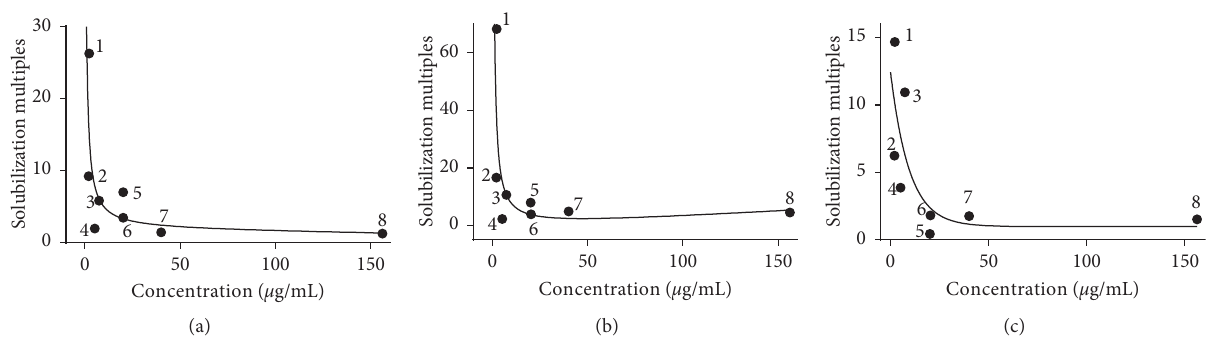
Figure 3: Relationship between solubilization and self-solubility of 8 flavonoids in NXDT, CCDT, GQDT. (a) NXDT; (b) CCDT; (c) GQDT; 1: quercetin; 2: baicalein; 3: baicalin; 4: luteolin; 5: daidzein; 6: rutin; 7: galuteolin; 8: daidzin. Table 2: Degradation rate constant ( K ) of flavonoids at pH 9/90 ° C.